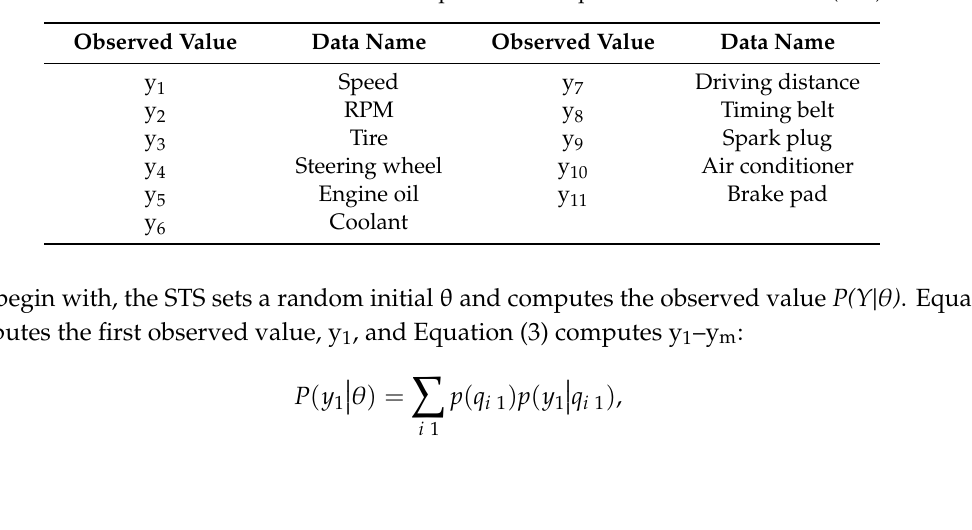
Table 2. Observed values that can be output from the speech-to-text submodule